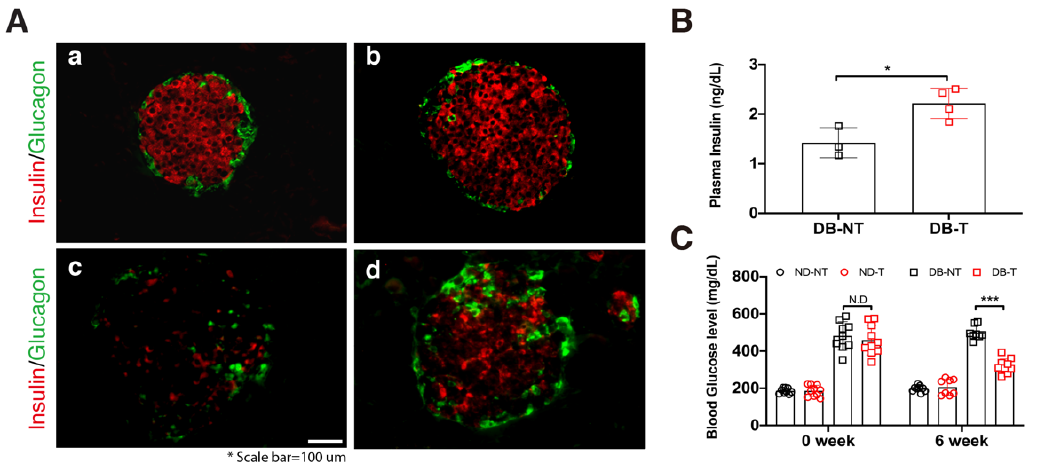
Figure 1. E ff ect of hydrolyzed silk fibroin (SF) on the pancreatic β -cells and blood glucose metabolism in the mouse model. ( A ) Immunofluorescence staining of the pancreatic islets in the normal (a: untreated non-diabetic mice (ND-NT), b: non-diabetic with hydrolyzed SF treatment (ND-T)), and diabetic (c: untreated db / db (DB-NT), d: hydrolyzed SF-treated db / db (DB-T)) mice. Slides were stained with Insulin (Alexa 594) and Glucagon (Alexa 488). Scale bar is indicated. ( B ) The plasma insulin levels in the db / db mice following 6 weeks of hydrolyzed SF treatment or not ( n > 3). Data are represented as mean ± SEM. Student’s t -test, two-tailed, * p < 0.05. ( C ) The blood glucose levels in each experimental group following 6 weeks of hydrolyzed SF treatment or not ( n > 7). Data are presented as mean ± standard error of the mean (SEM). One-way ANOVA, *** p <